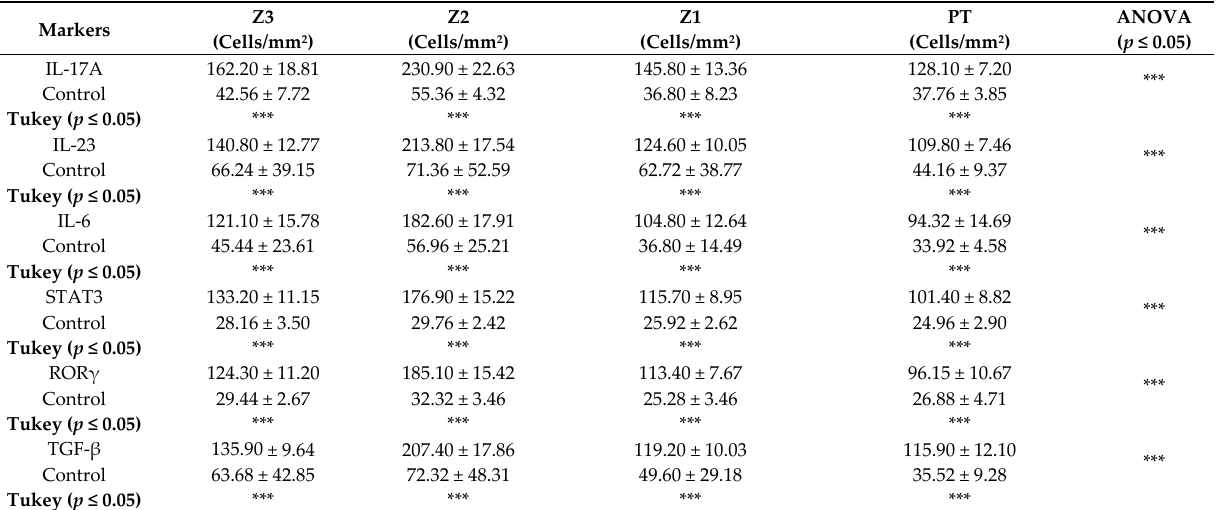
Table 3. Quantitative analysis (mean + standard deviation) of Th17 markers in the liver parenchyma (Z3, Z2, Z1, and PT) in 21 patients with fatal YF and 05 normal